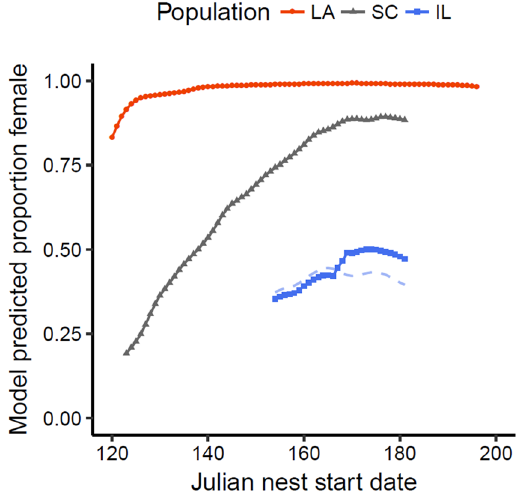
Figure 7. Sex ratios predicted for each population from the DDC Model across the nesting season. Sex ratios are averaged across all years by each nesting day, and a sliding 3-day average is depicted. Louisiana is shown with red circles, South Carolina with grey triangles, and Illinois with blue squares. Estimates for Louisiana and South Carolina use the population average sex ratio reaction norm (Fig. 3). Sex ratios in Illinois are portrayed using the population average sex ratio reaction norm (Fig. 3, dashed line), and the two season-specific reaction norms (Fig. 4, solid line with squares) to demonstrate the relative effect of the seasonal reaction norms on predicted sex